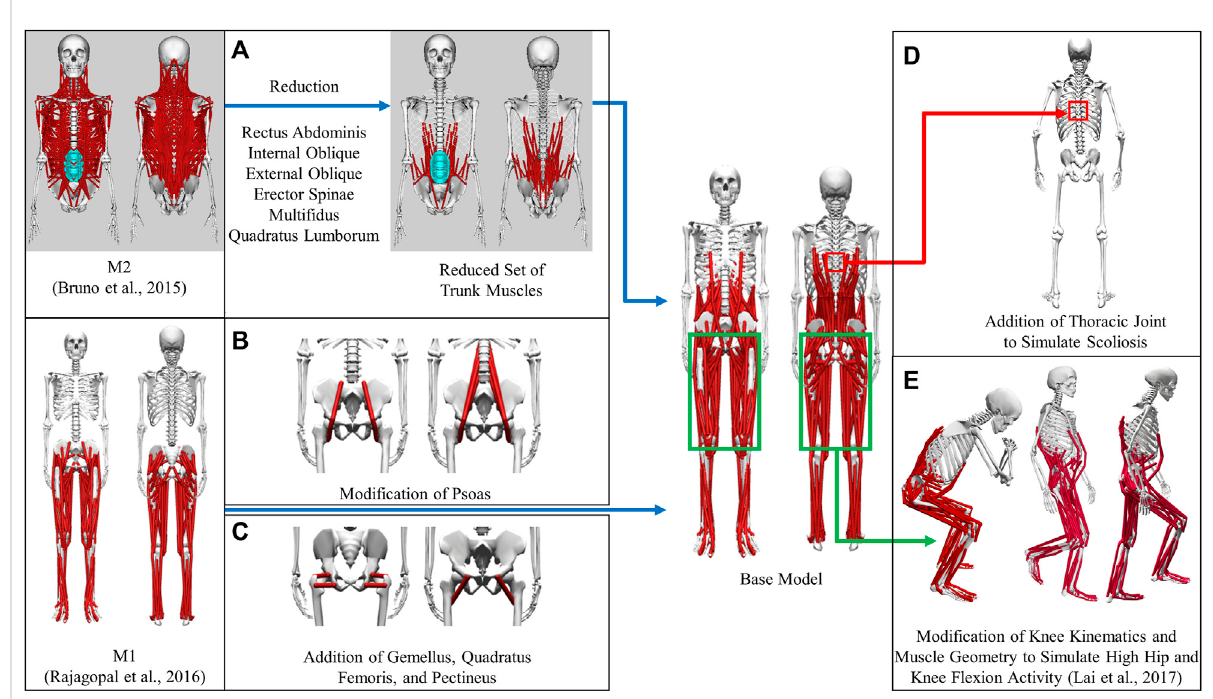
FIGURE 1 Development of the base model from generic models. (A) Transfer of a reduced set of trunk muscles from M2 to the base model. (B) Modi fi cation of psoas to place muscle origins on the spine and splitting the single-head psoas in M1 into the eventual 3 heads (C) Addition of gemellus, quadratus femoris, and pectineus to the base model (D) Creation of the thoracic joint to simulate scoliosis (E) Modi fi cation of knee joint kinematics and muscles to simulate high fl exion